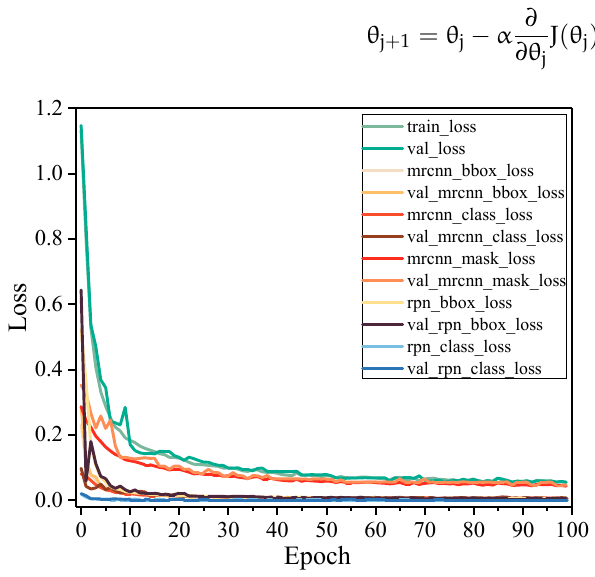
Figure 4. Iterative process